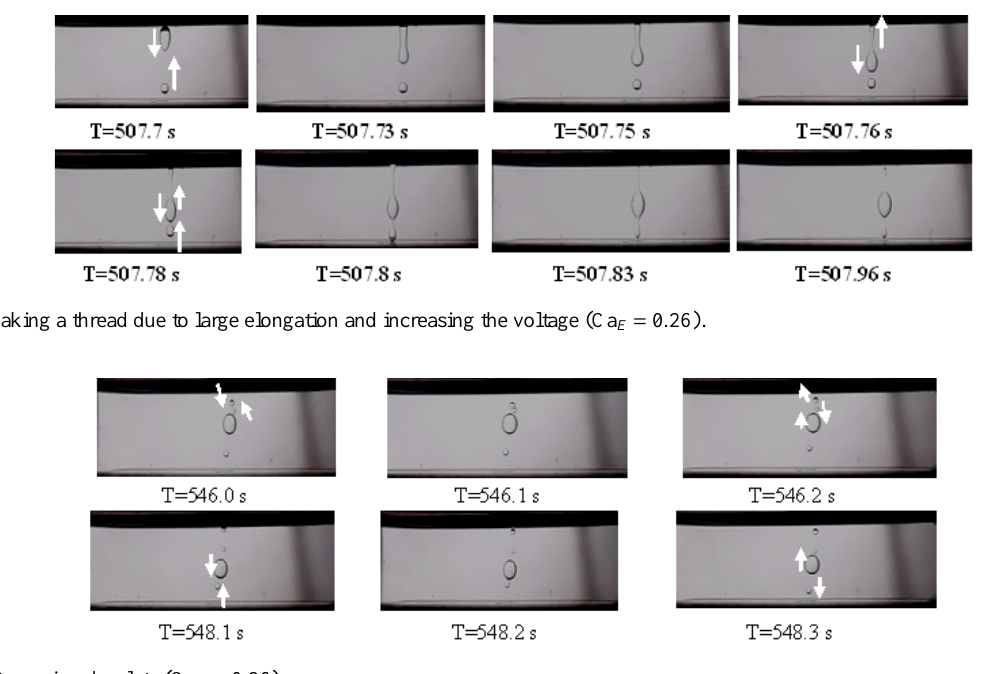
Figure 10. Bouncing droplets (Ca E = 0 .